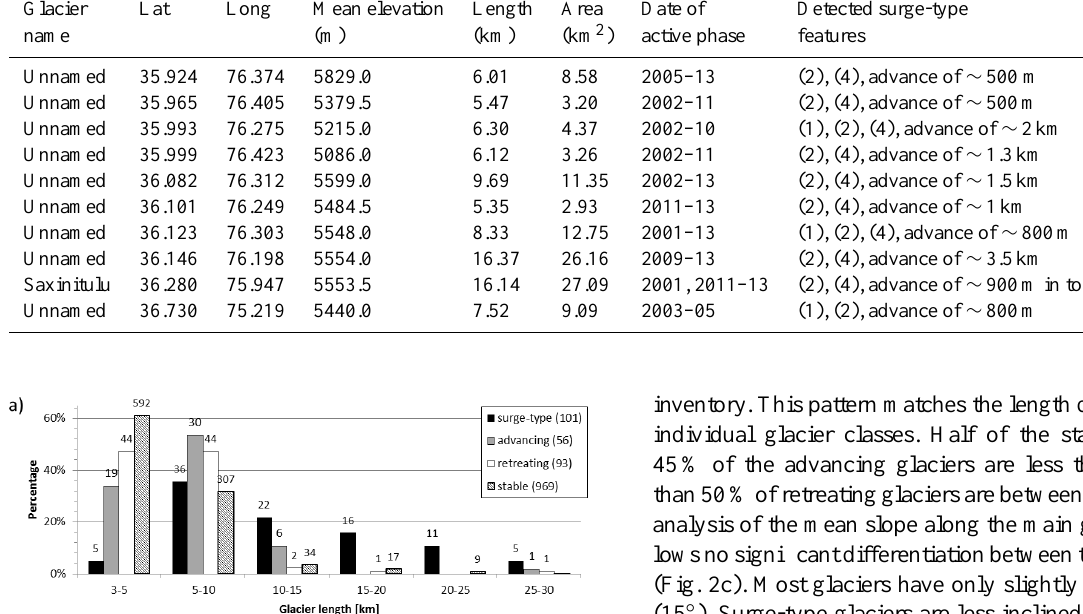
Table 3. New surge-type glaciers identified in this study. Surge-type features include (1) looped/folded medial moraines and surface foliation, (2) terminus advance, (3) terminus steepening and thickening, and (4) increased surface velocities (according to Copland et al., 2011). Glacier